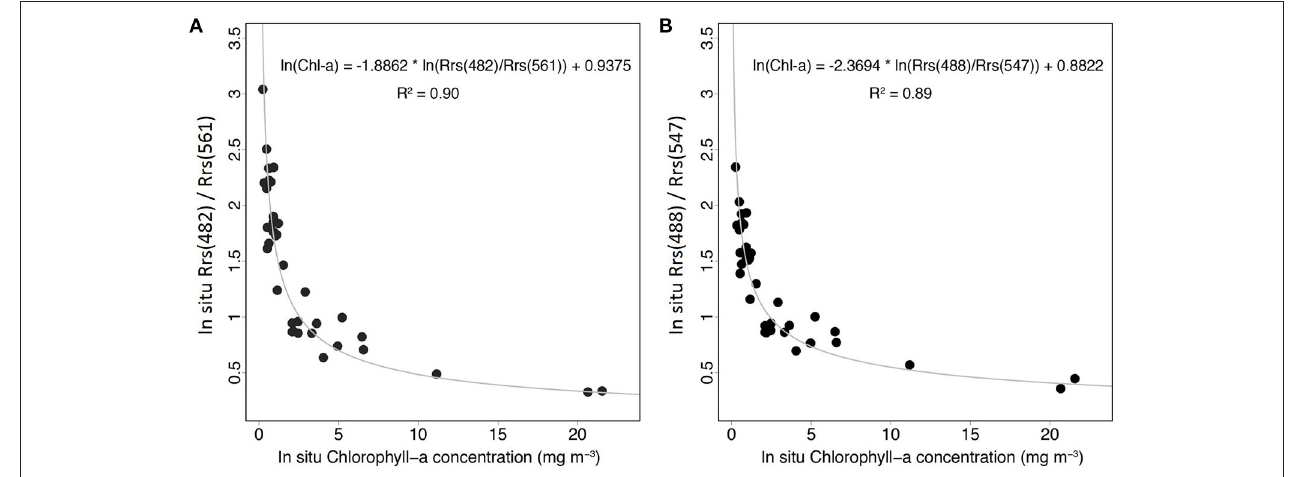
FIGURE 2 | Local empirical relationships between in situ surface chl-a concentrations and in situ blue-green Rrs : (A) OLI (blue: 482nm and green: 561nm), (B) MODIS (blue: 488nm and green: 547nm).